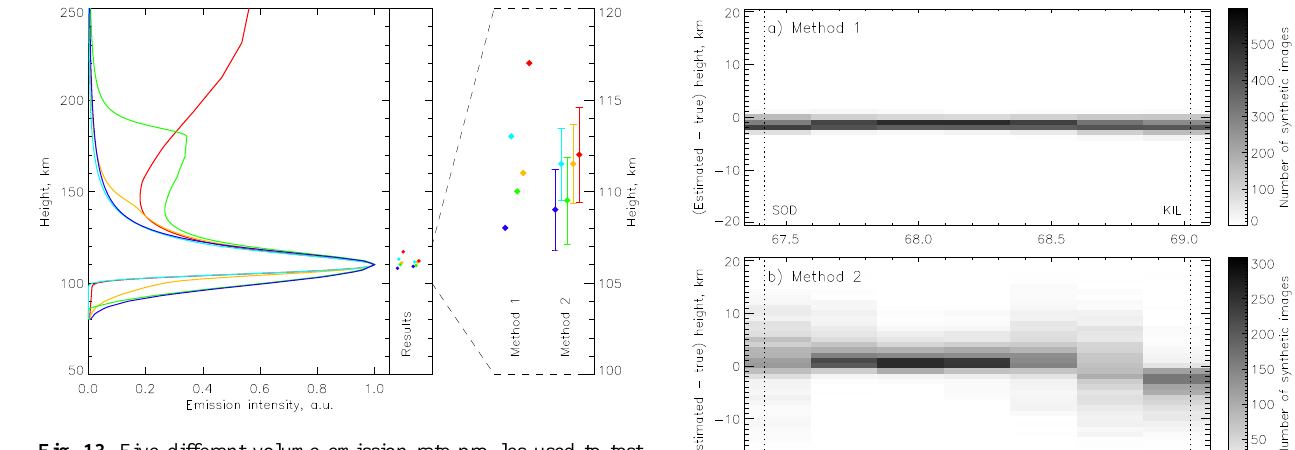
Fig. 13. Five different volume emission rate profiles used to test whether the methods respond to the peak emission height. The results from both methods are shown on the right of this figure. Fig. 14. Results from the analysis of synthetic arcs located north or south of the midpoint between the Sodankyl¨a and Kilpisj¨arvi stations. The same images were analysed using both methods, and results are shown as histograms for a) method 1 and b) method 2.